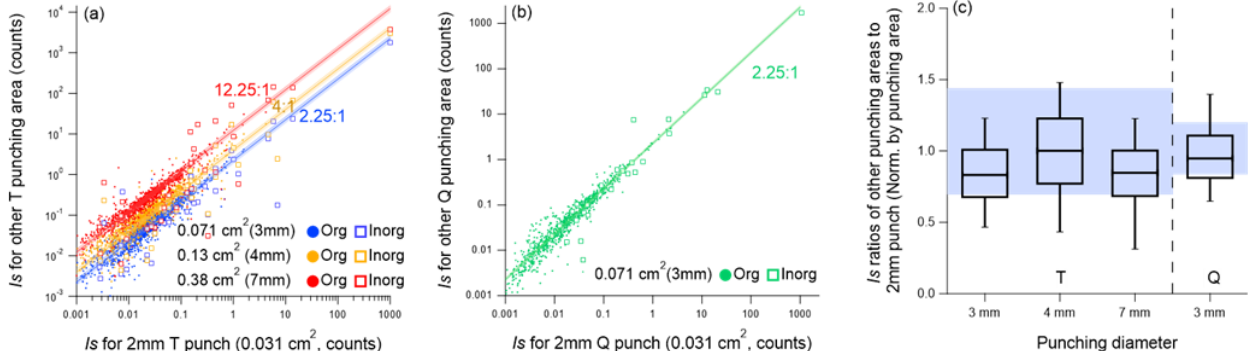
Figure 6. Comparison of the Is between signals from punches (a) with 3, 4, 7, and 2mm diameter for the same Teflon filter and (b) with 3 and 2mm diameter for the same quartz filter. The lines in panels (a) and (b) represent the punching area ratios. The shaded areas in panels (a) and (b) represent the area ratio plus or minus the relative errors (9% for quartz and 18% for Teflon) from the reproducibility tests. (c) The distribution of Is ratios normalized by the punching area ratios (3, 4, and 7 to 2mm diameter punches for Teflon and 3 to 2mm diameter punches for quartz). Within each box, the median (middle horizontal line), 25th and 75th percentiles (lower and upper ends of the box), and 10th and 90th percentiles (lower and upper whiskers) are shown. The shaded area in panel (c) represents the possible distribution of the Is ratios due to the relative error established from the 24h sample reproducibility tests (18% for Teflon and 9% for quartz filters). The upper and lower limits for the Teflon Is ratio distribution are calculated as (1 + 18%) / (1 − 18%) and (1 − 18%) / (1 + 18%), respectively. The upper and lower limits for the quartz Is ratio distribution are calculated as (1 + 9%) / (1 − 9%) and (1 − 9%) / (1 + 9%),